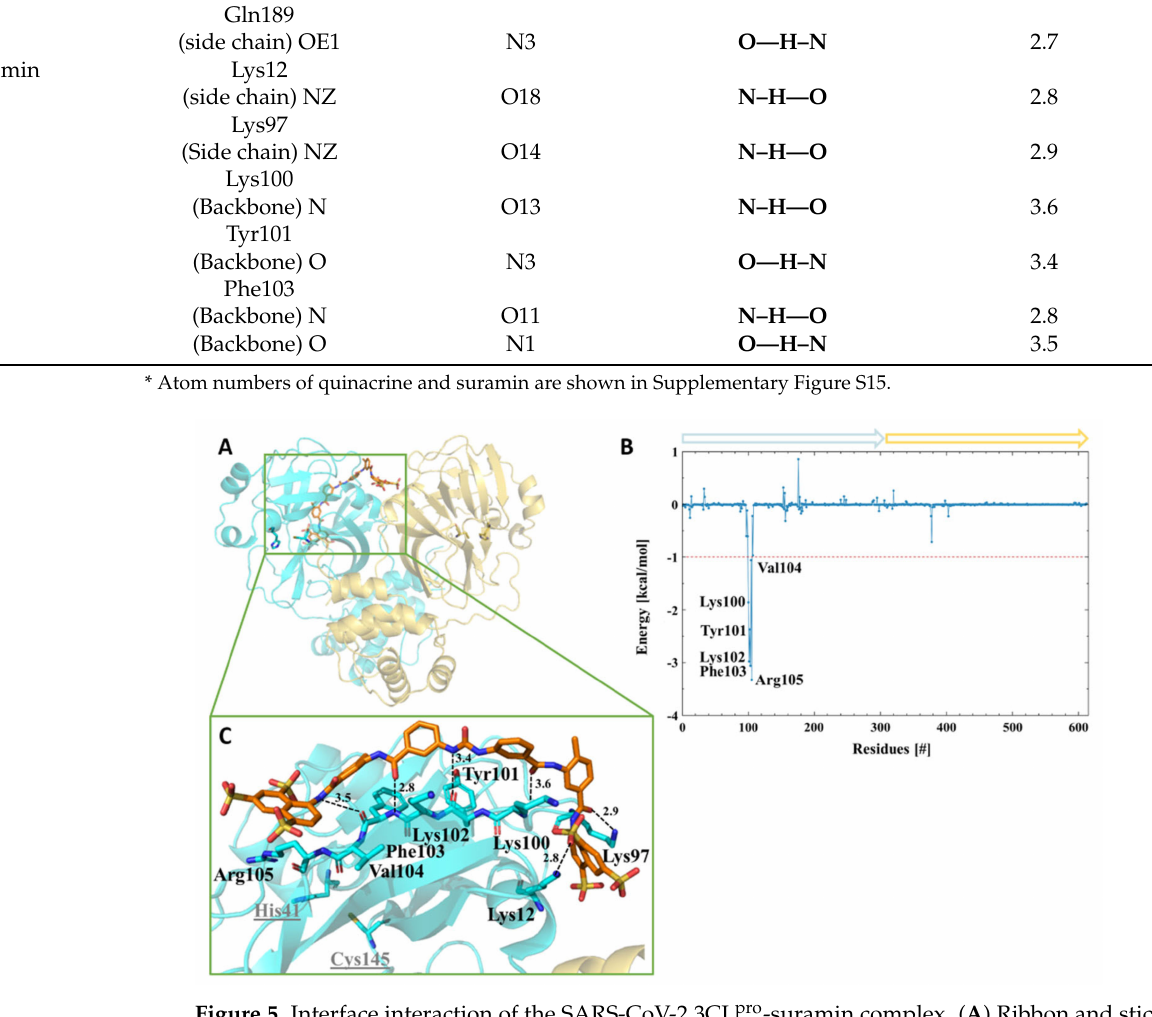
Figure 5. Interface interaction of the SARS-CoV-2 3CL pro -suramin complex. ( A ) Ribbon and sticks representation of the SARS-CoV-2 3CL pro -suramin complex after MD simulation. ( B ) Decomposition of the binding energy of the SARS-CoV-2 3CL pro -suramin complex. Arrows label protomer A (turquoise) and protomer B (gold). ( C ) SARS-CoV-2 3CL pro amino acids involved in the interaction with suramin based on MD